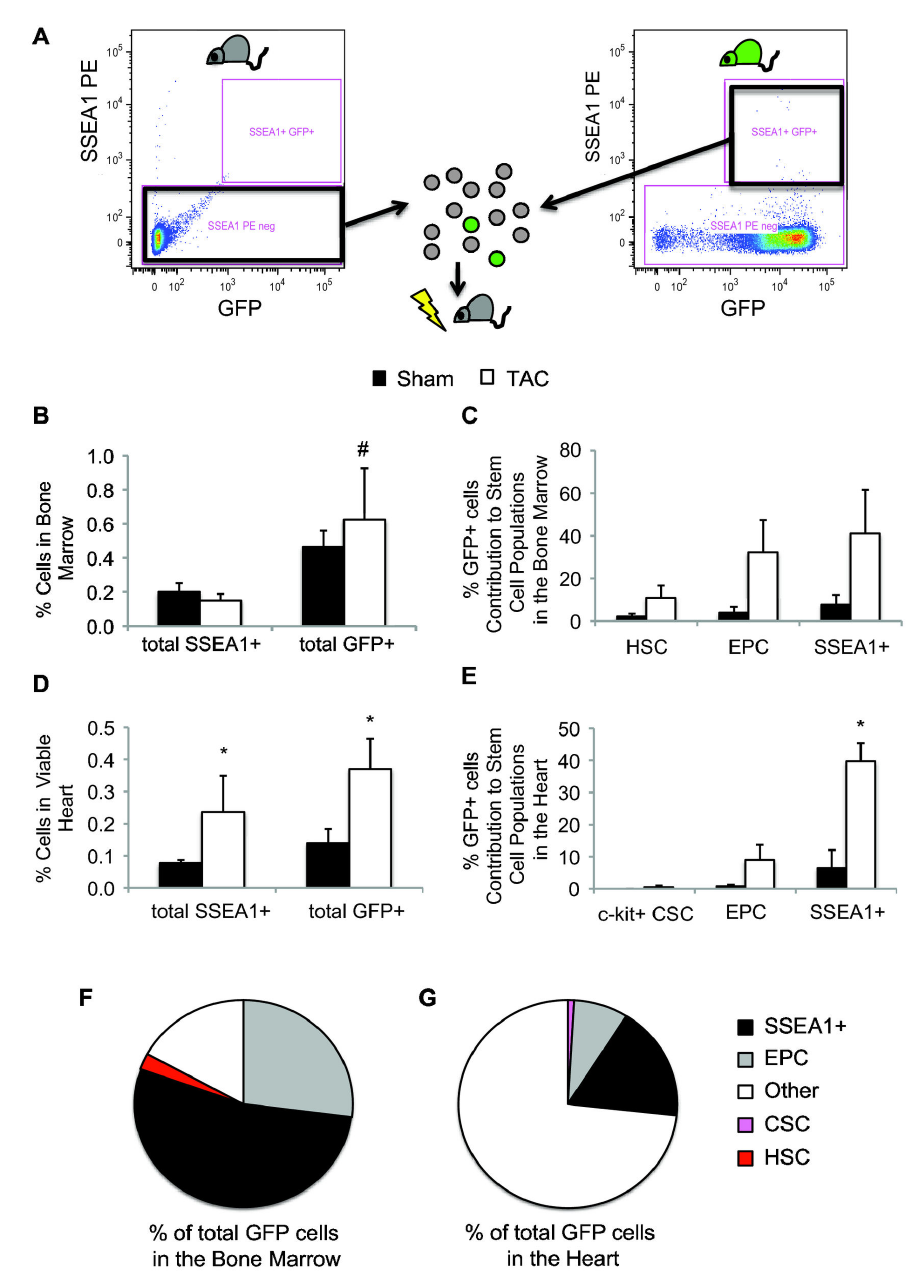
Figure 1. Fate of Bone Marrow SSEA1+ cells after TAC. (A) Experimental Protocol. SSEA1+ cells were depleted from the bone marrow (grey circles) of a C57 mouse (grey mouse) by FACS and replaced by bone marrow SSEA1+ cells from a GFP transgenic mouse (A1, green circles, green mouse). The chimeric bone marrow was injected into lethally irradiated C57 mice. Bar graphs from flow cytometry analysis of SSEA1+ and GFP+ cells in the bone marrow (B) and heart (D) from sham (black bars) and 7 days post- TAC (white bars). The percentage of GFP+ cells contributing to stem cell populations in the bone marrow (C) and heart (E) in sham and TAC (7 days post) animals was analyzed by flow cytometry. Bone marrow SSEA1+ cells contributed to the HSC and EPC, and SSEA1+ cell populations but not to the CSC population. The percentage of SSEA1+ (black wedge), CSC (pink wedge), EPC (grey wedge), and HSC (red wedge) of the total GFP+ cell pool in the bone marrow (F) and myocardium (G) 7 days post-TAC. n = 3-5 per group. * P < 0.05 compared to sham. # P = 0.05 compared to SSEA1+ cells. Abbreviations: SSEA1, stage-specific embryonic antigen 1; TAC, trans-aortic constriction; FACS, fluorescence-activated cell sorting; GFP, green fluorescent protein; HSC, hematopoietic stem cells; EPC, endothelial progenitor cells; CSC, cardiac stem cells. doi: 10.1371/journal.pone.0068528.g001 PLOS ONE |